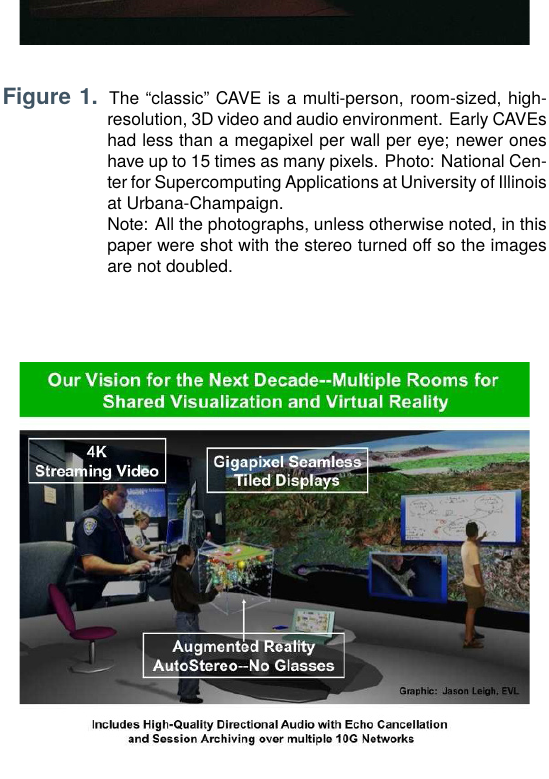
Figure 2. A composite rendering of the EVL/Calit2 vision of a future collaboration room. Illustration: Jason